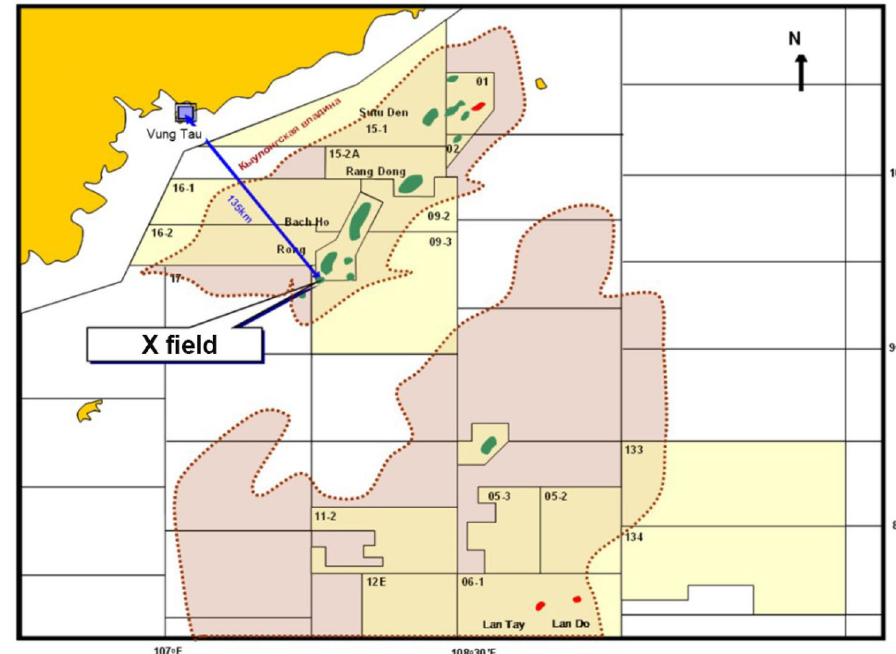
Fig. 2 Location of studied area in Cuu Long